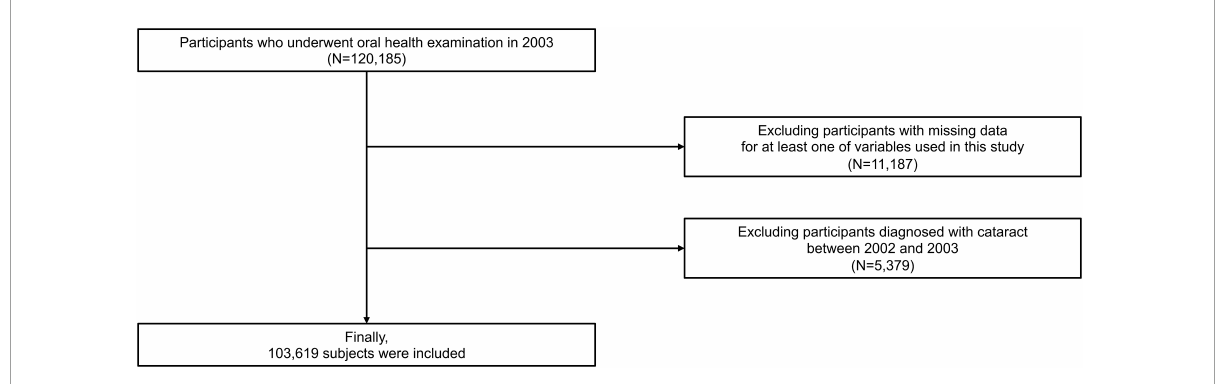
FIGURE1 Flow chart of study